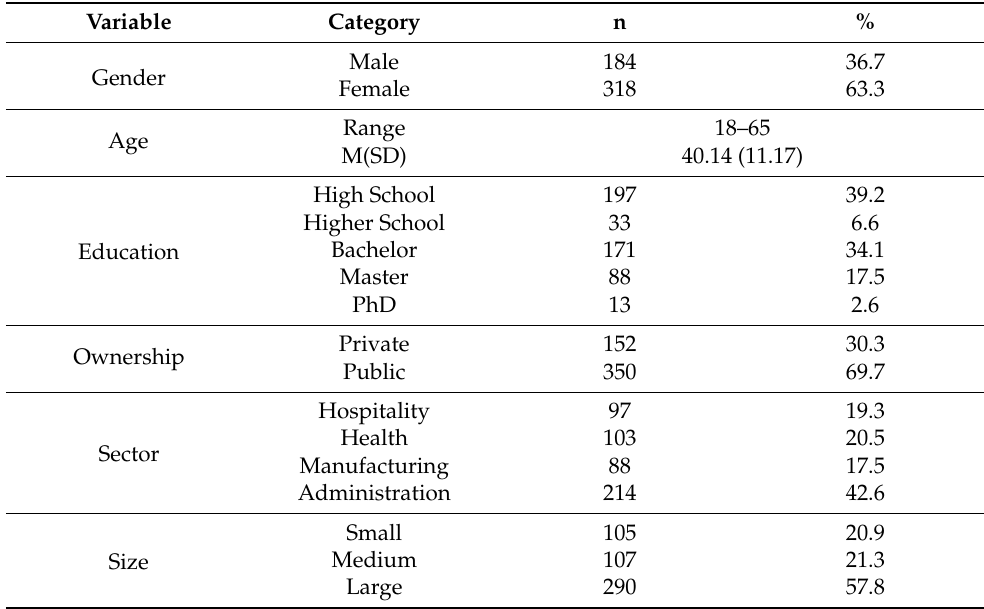
Table 2. Characteristics of the sample (N =